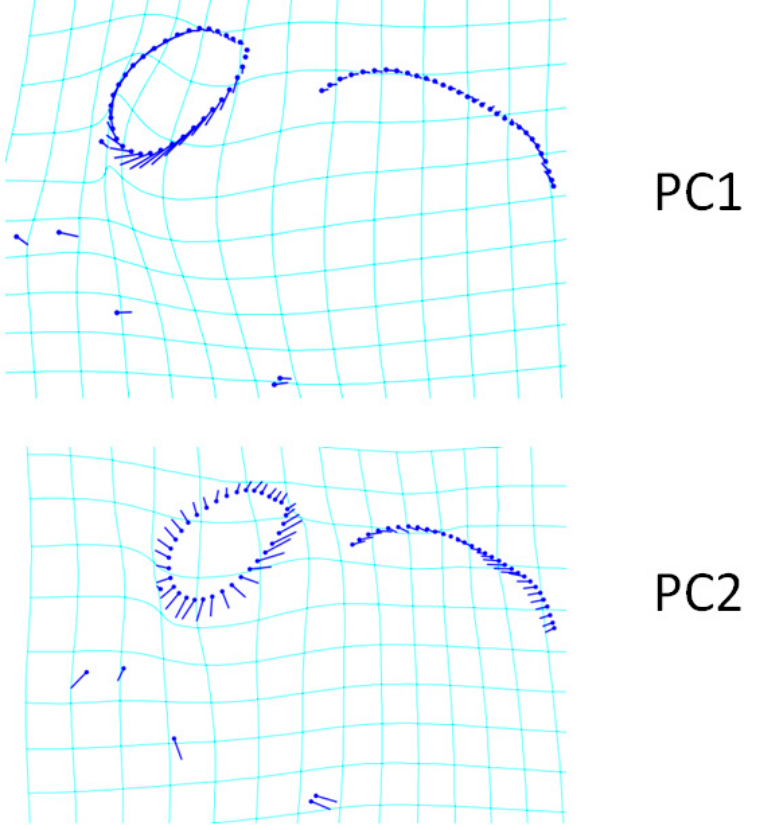
Figure 2. Transformation grid of changes in skull shape of PC1 (50.67%) and PC2 (9.82%) (dorsal view). Transformation grids illustrate the shape changes from the overall mean along PC1 and PC2. The length of the lines extending from the points represents the amount and direction of change.